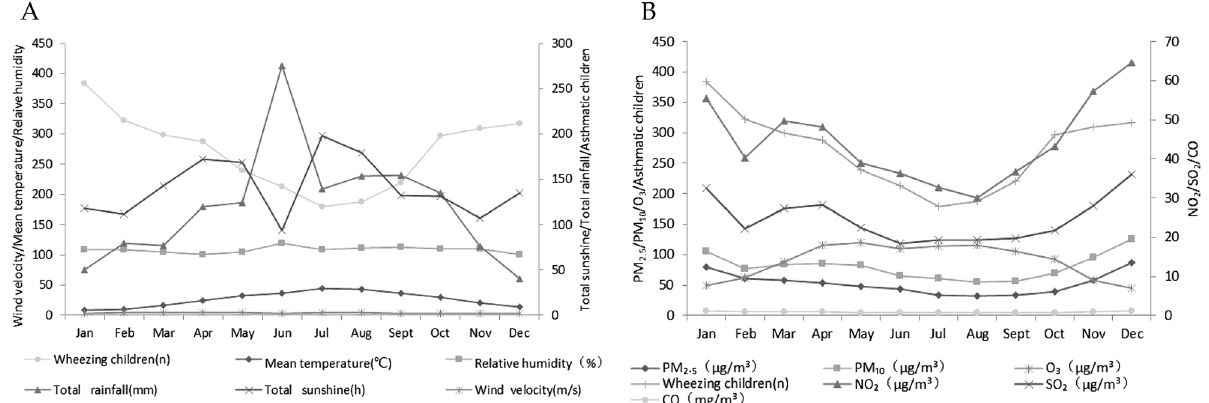
Figure 2. Monthly distribution of meteorological ( A ) and environmental ( B ) factors among children hospitalized with wheezing diseases. ( A ) Mean temperature, relative humidity, total rainfall, total sunshine, wind velocity and wheezing children number from 2013 to 2017 in Suzhou. ( B ) PM 2.5 , PM 10 , O 3 , NO 2 , SO 2 , CO and wheezing children number from 2013 to 2017 in Suzhou. Figures were generated using Adobe Illustrator version CC 2018 (https:// www. adobe. com/ cn/ produ cts/ illus trator. html).